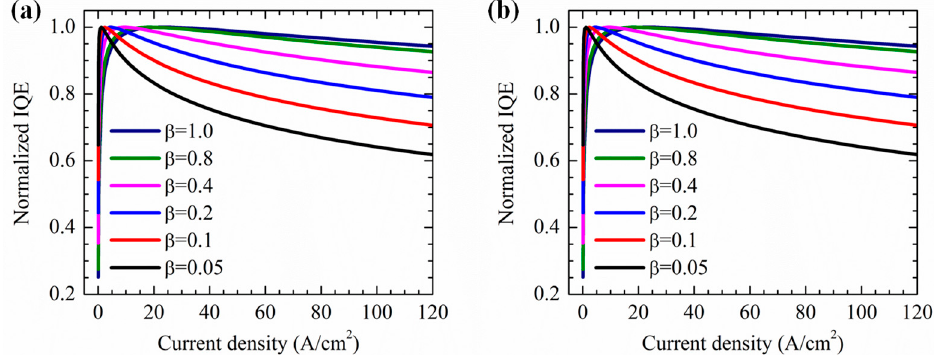
Figure 5. Calculation results of normalized IQE versus current density with ( a ) β varied from 0.05 to 1.0 and ( b ) well thickness ranged from 3 to 15 nm.